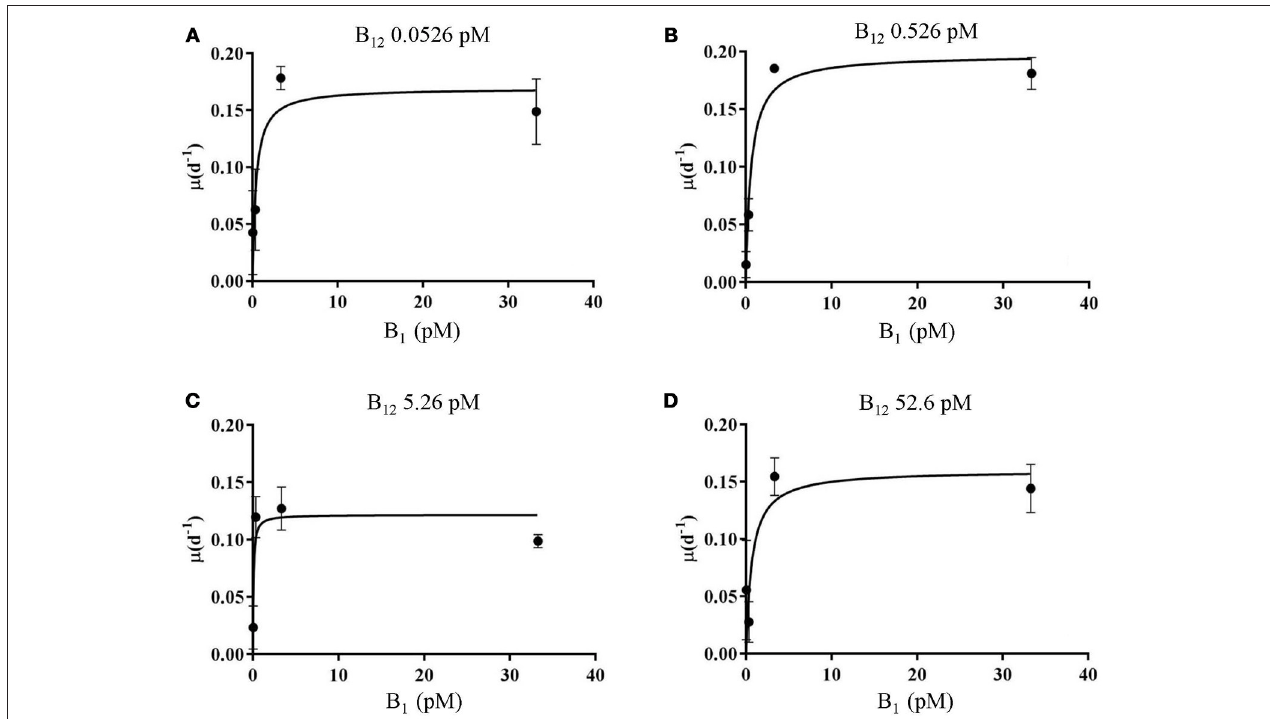
FIGURE 1 | Vitamin B 1 vs. B 12 growth kinetics curve for L. polyedrum . The data plotted are from 16 ( n (A) 0.0526, (B) 0.526, (C) 5.26, (D) 52.6 pM of B 12 , and 0.0333, 0.333, 3.33, and 33.3 pM of B 1 . Error bars represented one standard deviation ( n Michaelis–Menten model is plotted, K s and µ max are summarized in Table 1